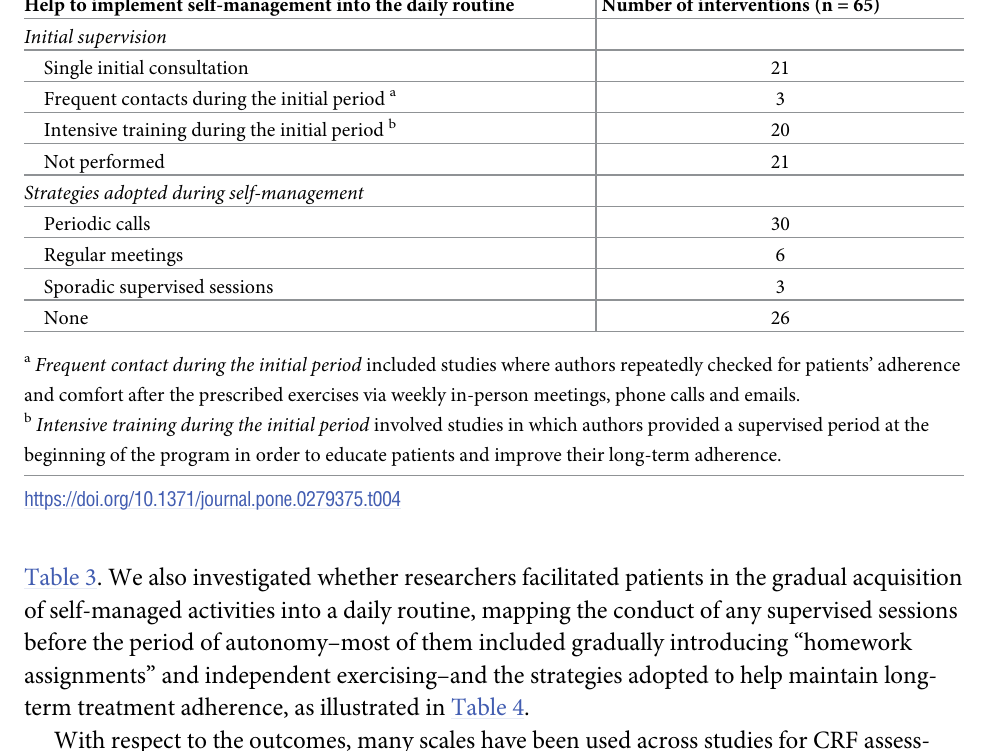
Table 4. Initial supervision to the interventions and strategies to increase cancer survivors’ assimilation of self- management in their routine. Help to implement self-management into the daily routine